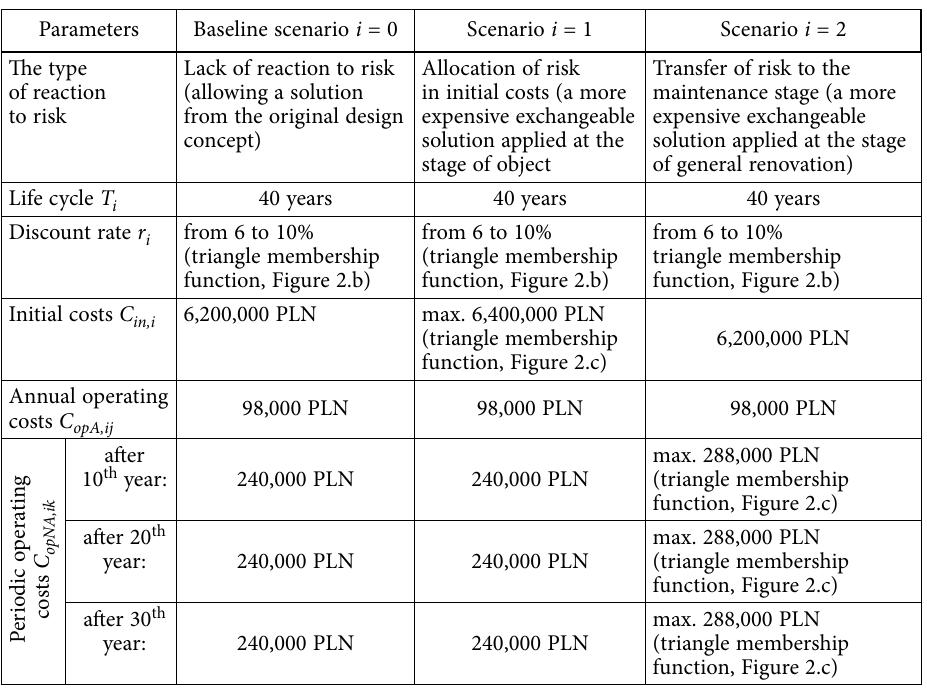
Table 6. Data for the life cycle cost analysis